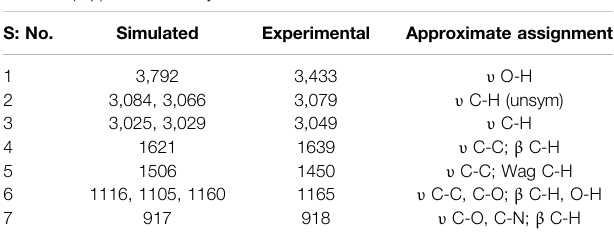
TABLE2| Simulated IRfrequencies(incm − 1 )of epi-CD (gasphase)attheB3LYP/ 6-311+G(d,p) level of